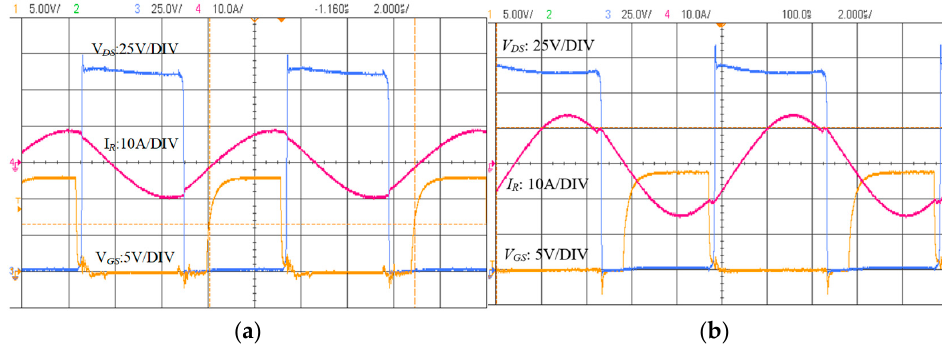
Figure 9. The measured waveforms of the LLC converter when the system is operated at ( a ) 500 W ( b ) 1 kW.